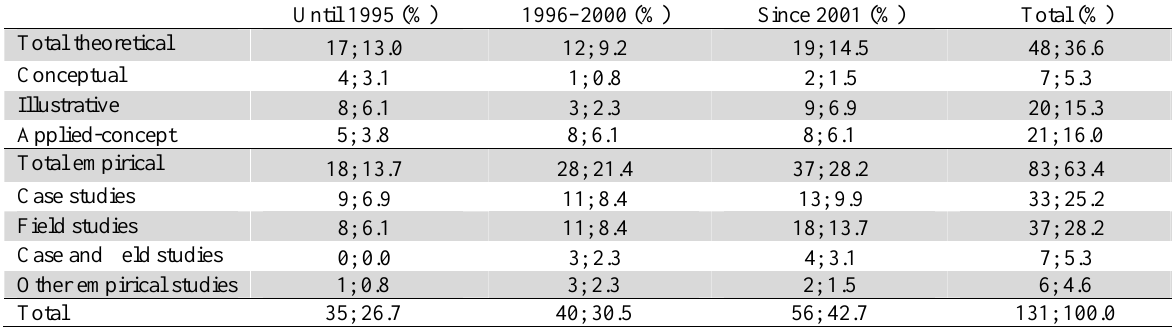
The chronological classification of outsourcing researches